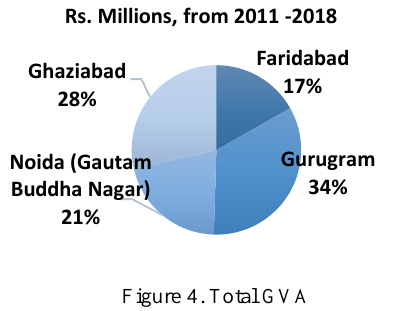
Figure 4. Total GVA